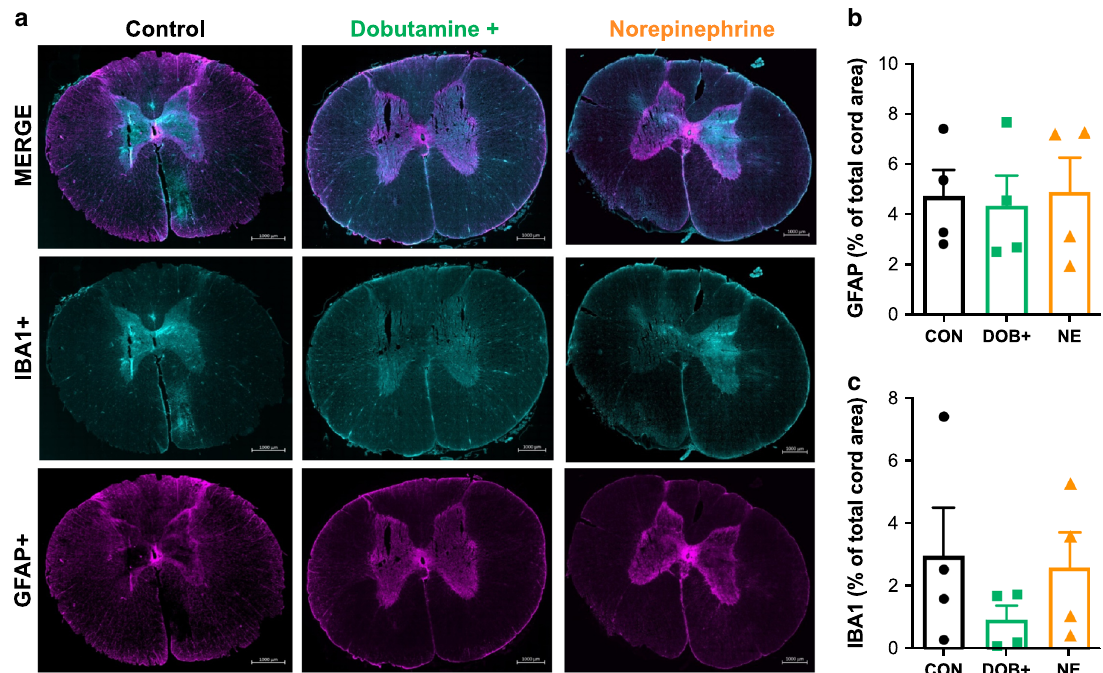
Fig. 5 Glial and in fl ammatory activation in the acutely injured spinal cord epicentre. a Representative images are shown for control (left) animals, and animals receiving hemodynamic management with high-dose dobutamine (middle) and norepinephrine (right). Merged stains (top) are shown for ionized calcium binding adaptor molecule 1 (IBA1 + , middle) and glial fi brillary acidic protein (GFAP + , bottom). Group data are shown for immunohistochemical analyses of GFAP ( b ) and IBA1 ( c ). Bars plots represent means and error bars represent s.d. No signi fi cant differences were detected between animals in control (CON), high-dose dobutamine (DOB + ), and norepinephrine (NE) groups. n = 4 per group for immunohistochemical analyses. Source data are provided as a Source Data fi